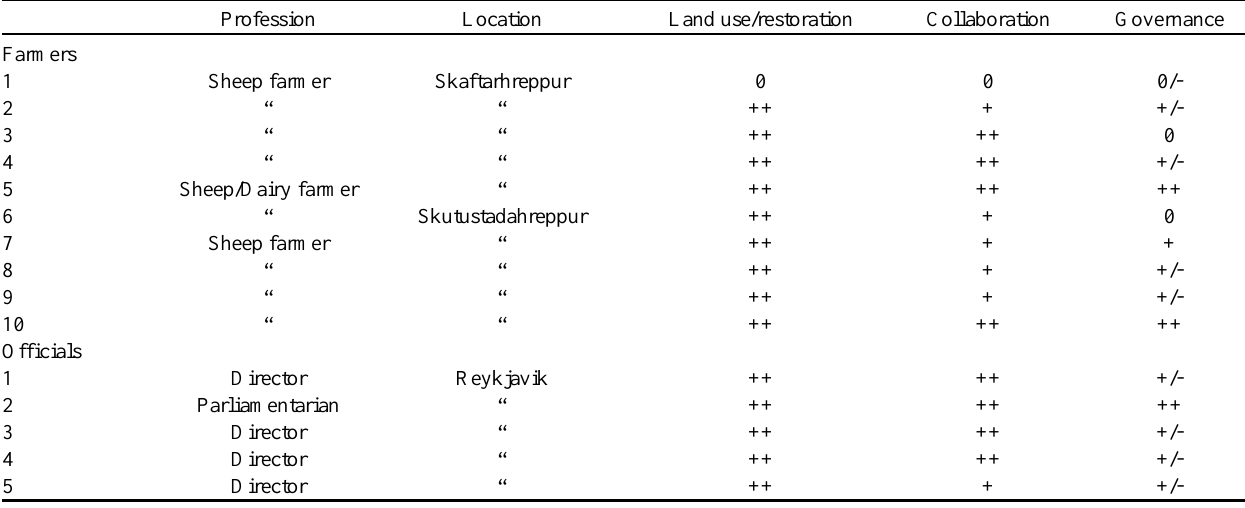
Table 2. An overview of the participants’ attitudes on land use/restoration, collaboration, and governance.